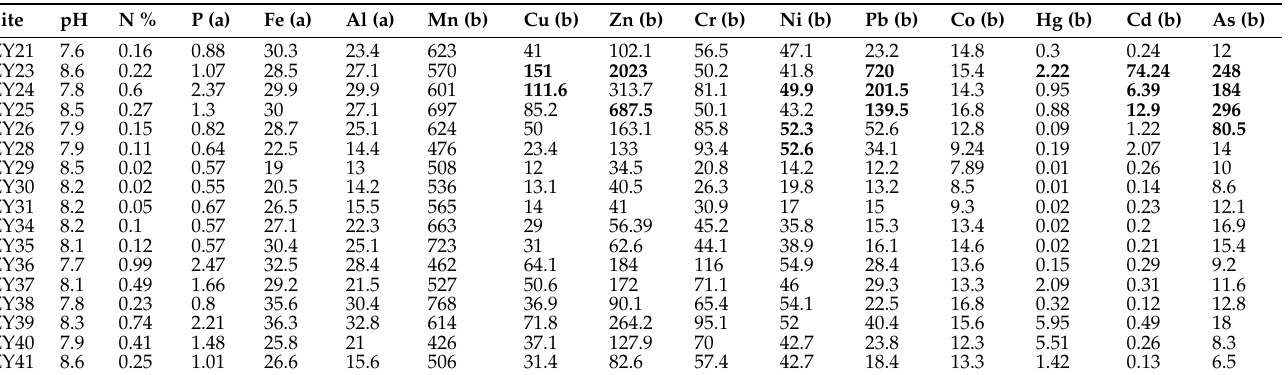
Table 2. The pH H20 , metal and nutrient concentrations of the sediments in the different sampling sites with probable effect concentrations on the biota (PEC) adapted from MacDonald et al. (2000) for As, Cd, Cu, Pb, Hg, Ni and Zn and Persaud et al. (1993) for Mn and Co. Metal concentrations over the (PEC) are in bold. Sediments concentration: dry weight (a) g/kg and (b) mg/kg. Borruso et al. [1].